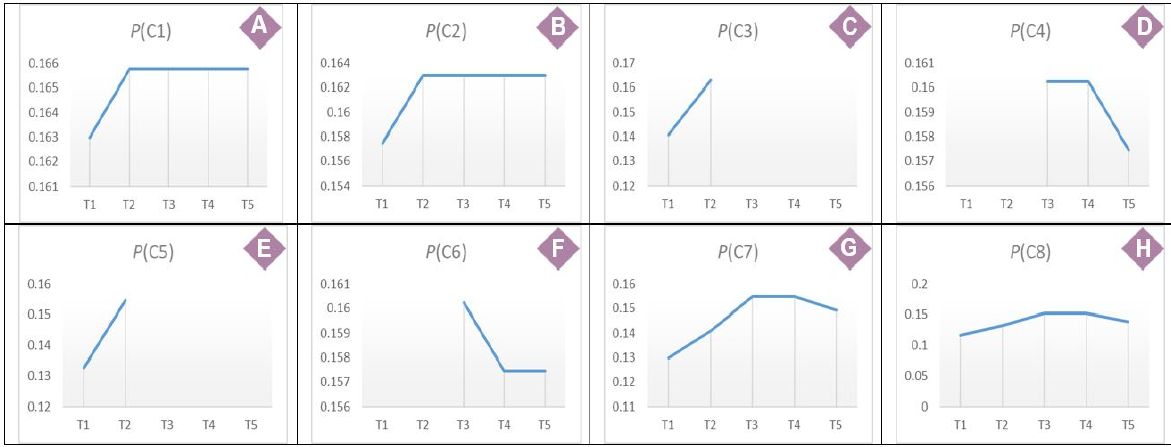
Figure 9. Probability calculations of the HPC fault mode.